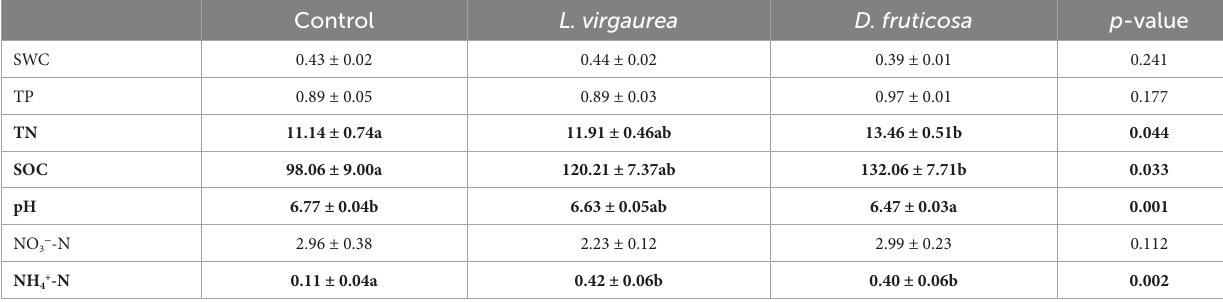
TABLE 1 Effects of different plant types on soil physicochemical properties (Mean ± SE).